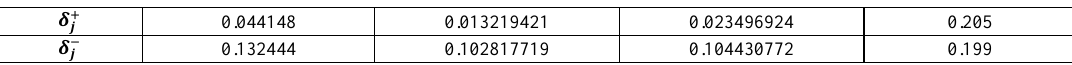
Table 5. Best and worst ideal solution.